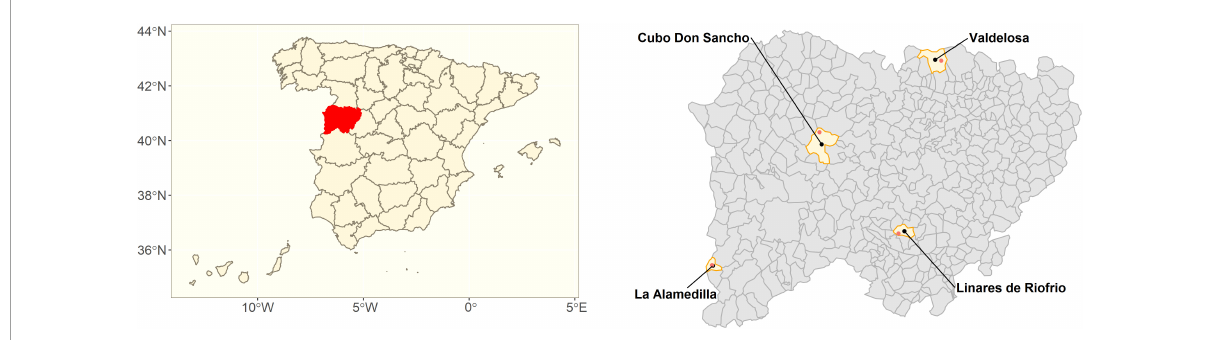
FIGURE1 Location of sampling sites. (Left) Map of Spain’s provinces, the sampled Salamanca province is highlighted in red. (Right) Close up of Salamanca province. Sampled municipalities are highlighted in yellow. Red dots correspond to sampling sites.